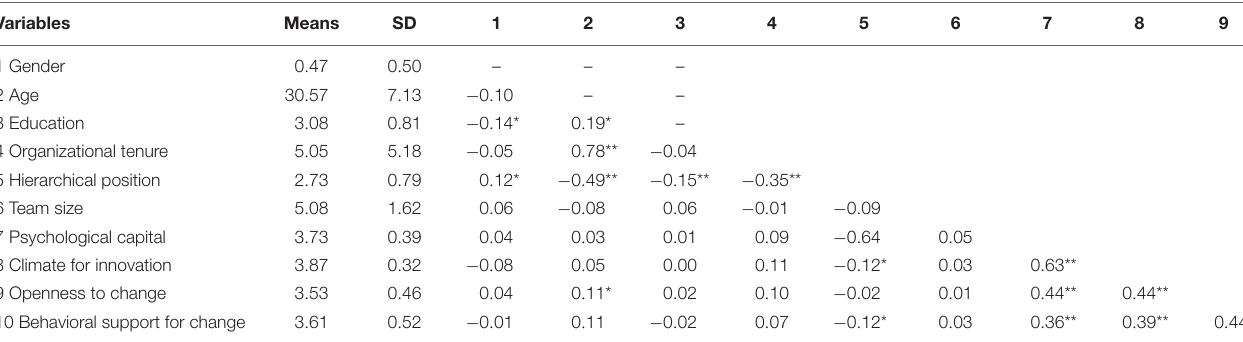
TABLE 2 | Means, standard deviations, and correlations for all variables.